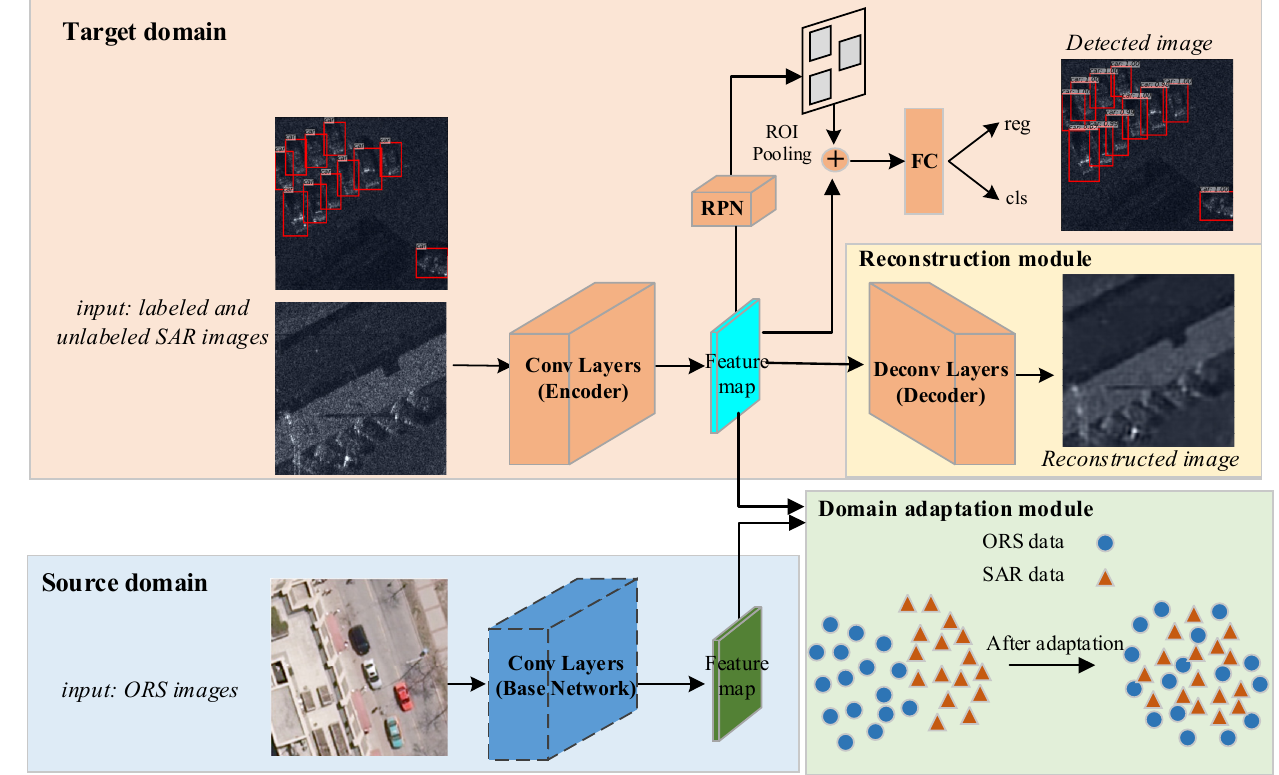
Figure 2. The architecture of the FDDA for the ORS images and the SAR images. The ORS and SAR images are, respectively, projected onto the latent space to obtain the feature maps via the corresponding base networks. In the decoding module, the feature maps of SAR data are fed to the decoding module consisting of deconvolution layers to reconstruct the input SAR images. The domain-adaptation module used the MMD criterion to constrain the learning of the features of the two domains. Moreover, the feature maps of the labeled SAR images are fed to the RPN and ROI head to obtain the detected results. The dashed line indicates fixed network parameters. Table 1. Overall architecture of the encoder and decoder.